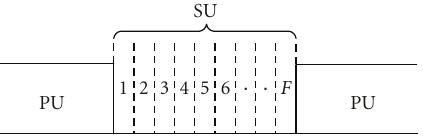
Figure 5: Single-user case with F subcarriers in one spectrum hole.